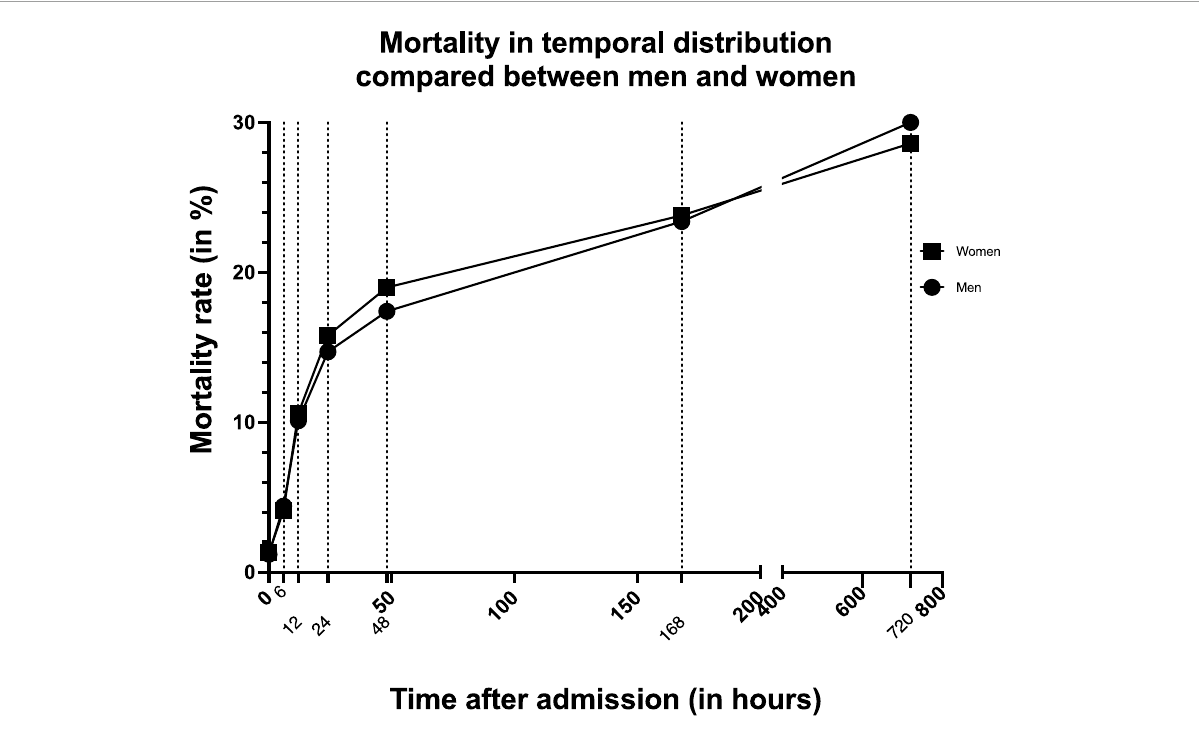
FIGURE1 Graph showing mortality rate in temporal distribution compared between men and women. Dotted lines indicate the different measurement